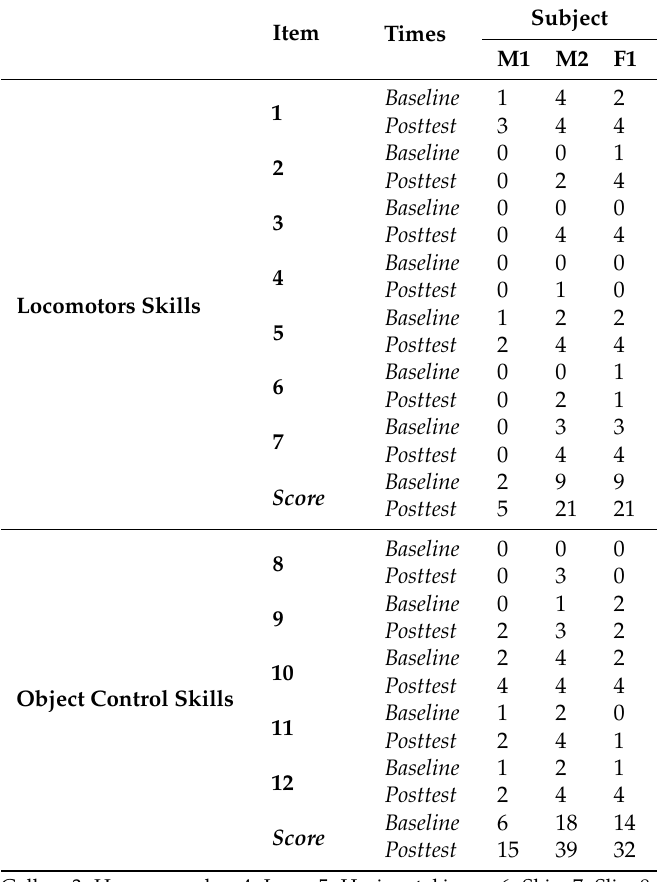
Table 3. Evaluation of locomotors and object control skills after the multi-systemic therapy program in